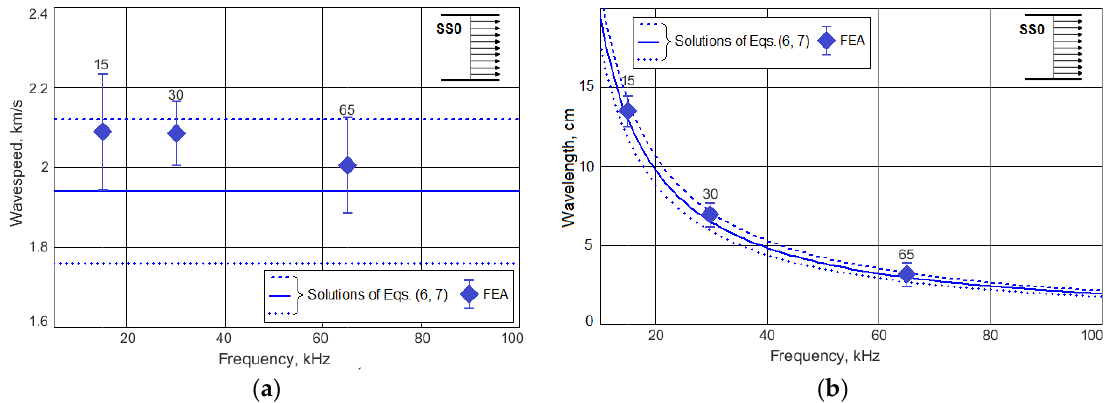
Figure 6. The dispersion curves for the wavespeed ( a ) and wavelength ( b ) of the horizontally polarized SS0 wave that can be excited in the studied panel at the frequencies 10–100 kHz together with the results of FE simulation.